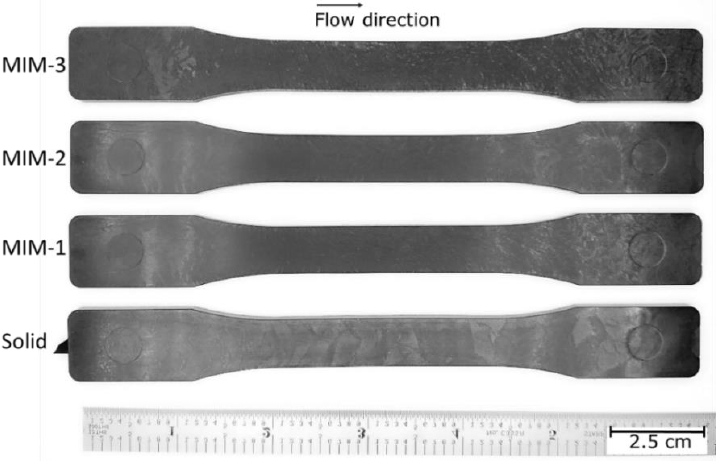
Figure 5. Surface characteristics of various molded samples.